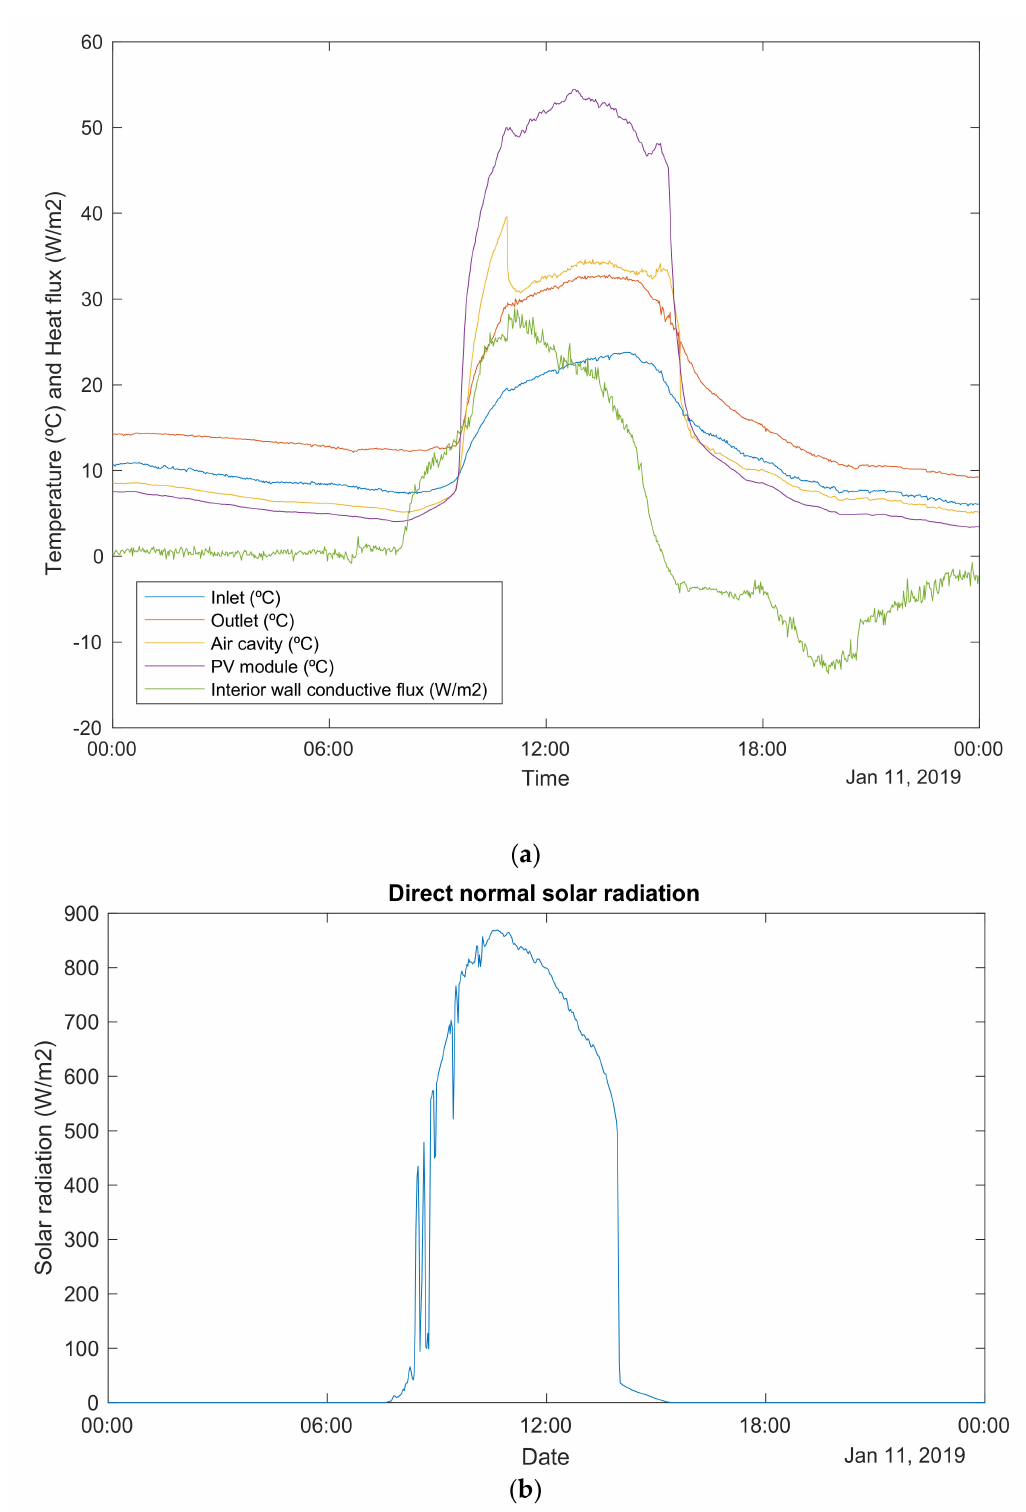
Figure 11. Daily behaviour: ( a ) the BIPVT system under manual operation, opened at 10:45 h and closed at 15:15 h, ( b ) direct normal solar radiation on the weather